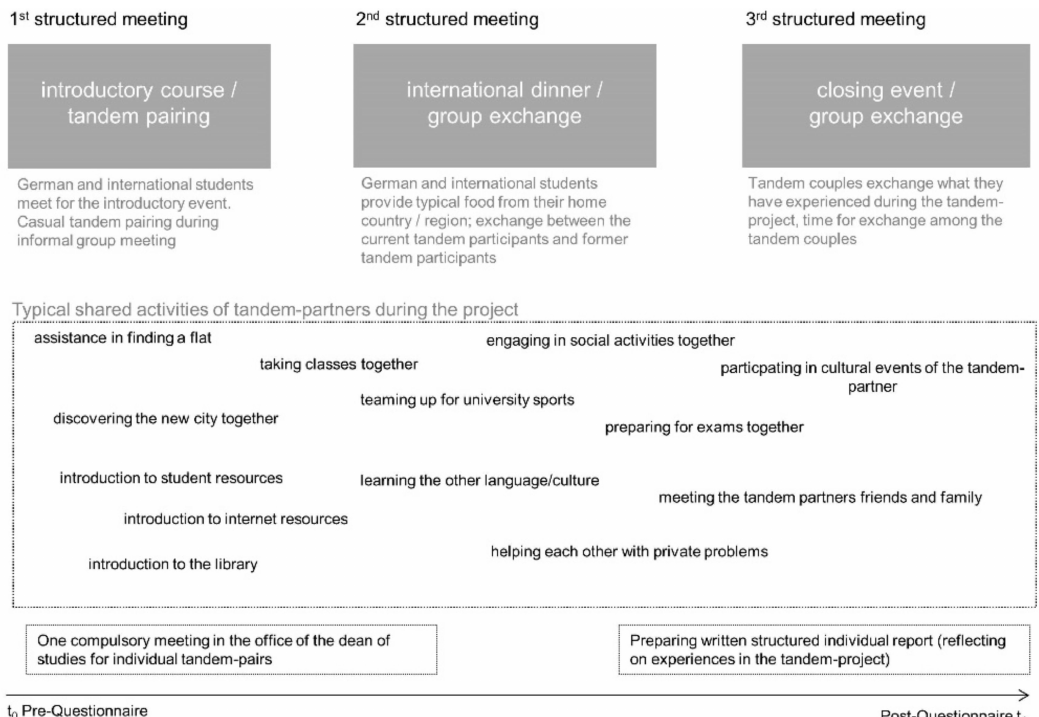
Figure 1. Graphical overview of components of the tandem program